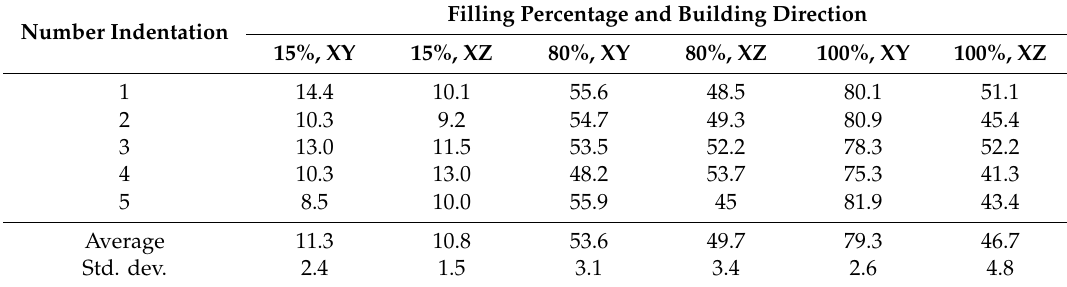
Table 4. Hardness values in N / mm 2 .